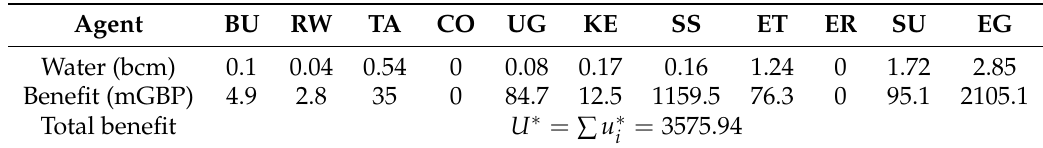
Table 4. Water resource allocation results in centralised manner (CP). Burundi(BU), Rwanda(RW),